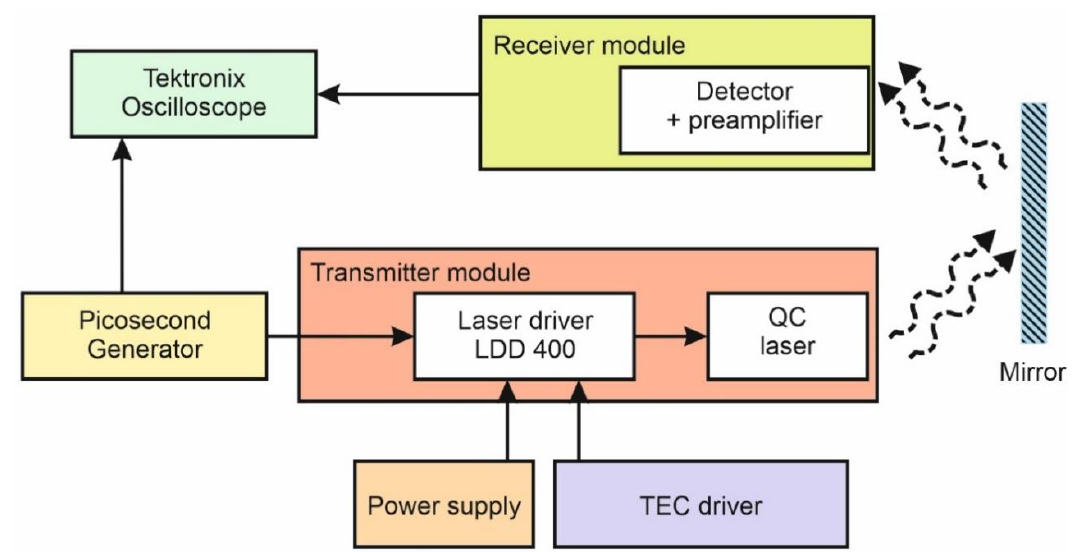
Figure 4. Photo of the receiving ( a ) and transmitting ( b ) modules of the FSO link.